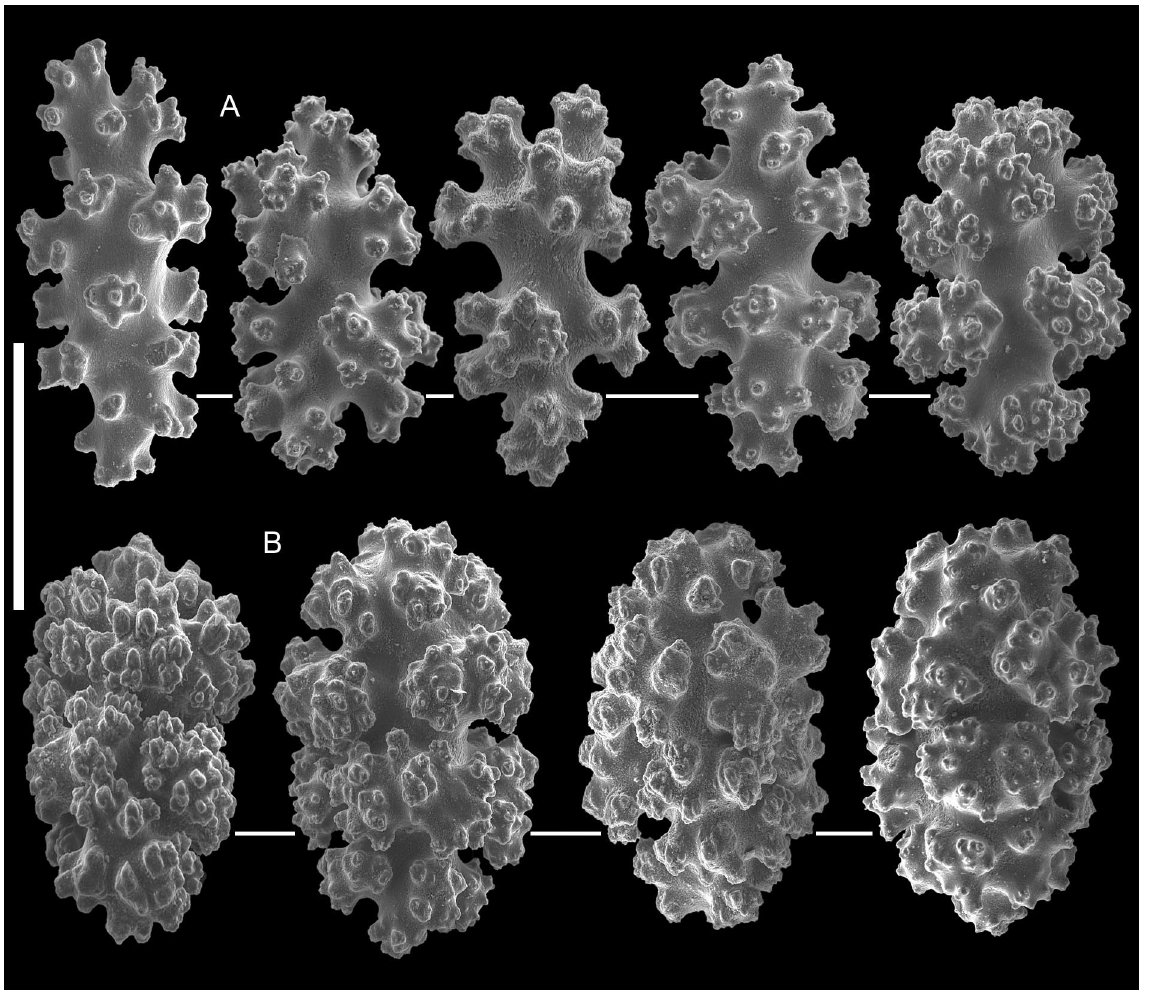
Fig. 4. Calcigorgia herba sp. nov., holotype MIMB 20744, sclerites from the coenenchyme. A . Well calcified capstans (8-radiate). B . Ovals. Scale bar = 0.1